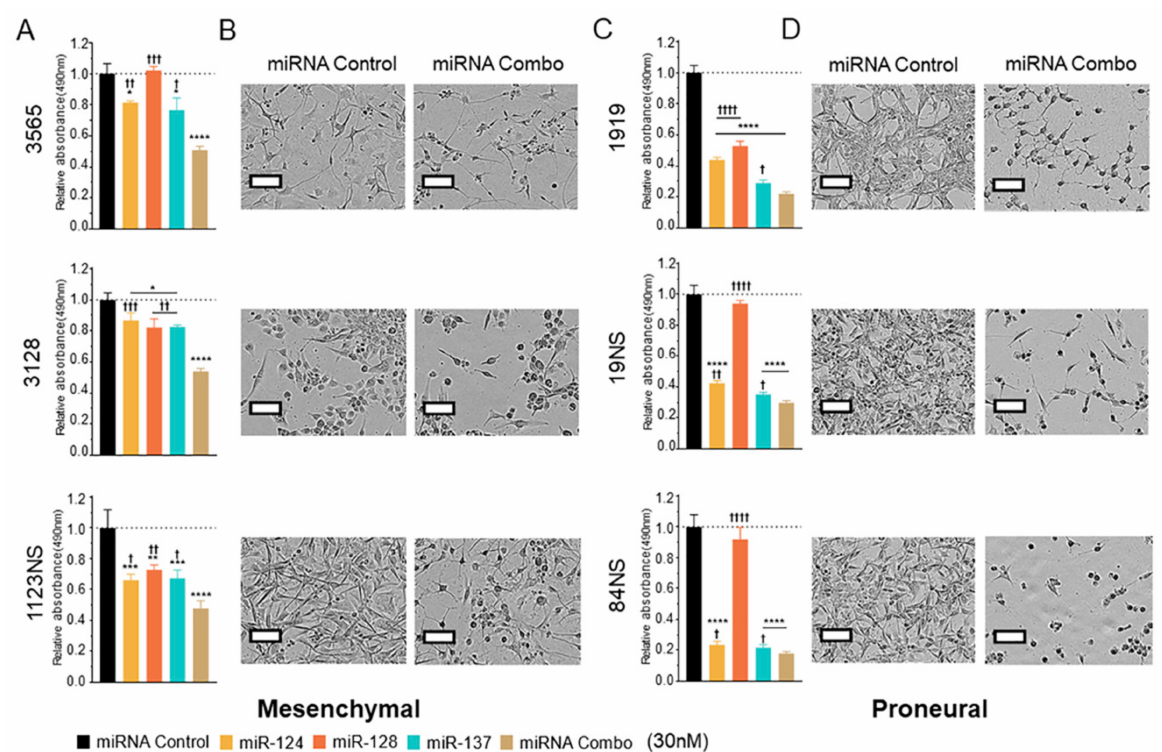
Figure 4. miRNA combination inhibits glioma stem cell phenotype. ( A ) Mesenchymal glioma stem cell (GSC) viability 120 h after reverse transfection with 30 nM of single and combined miRNA mimics. ( B ) Phenotypic changes of GSCs in ( A ). ( C ) Proneural GSC viability 120 h after reverse transfection with 30 nM of single and combined miRNA mimics. ( D ) Phenotypic changes of GSCs in ( C ). A one-way ANOVA with Tukey test for multiple comparisons was utilized for all experiments. p -values for comparisons against miRNA control: * p < 0.05; ** p < 0.01; *** p < 0.001; **** p < 0.0001. p -values for comparisons against miRNA Combo: † p < 0.05; †† p < 0.01; ††† p < 0.001; †††† p < 0.0001. Scale bar represents 100 µ